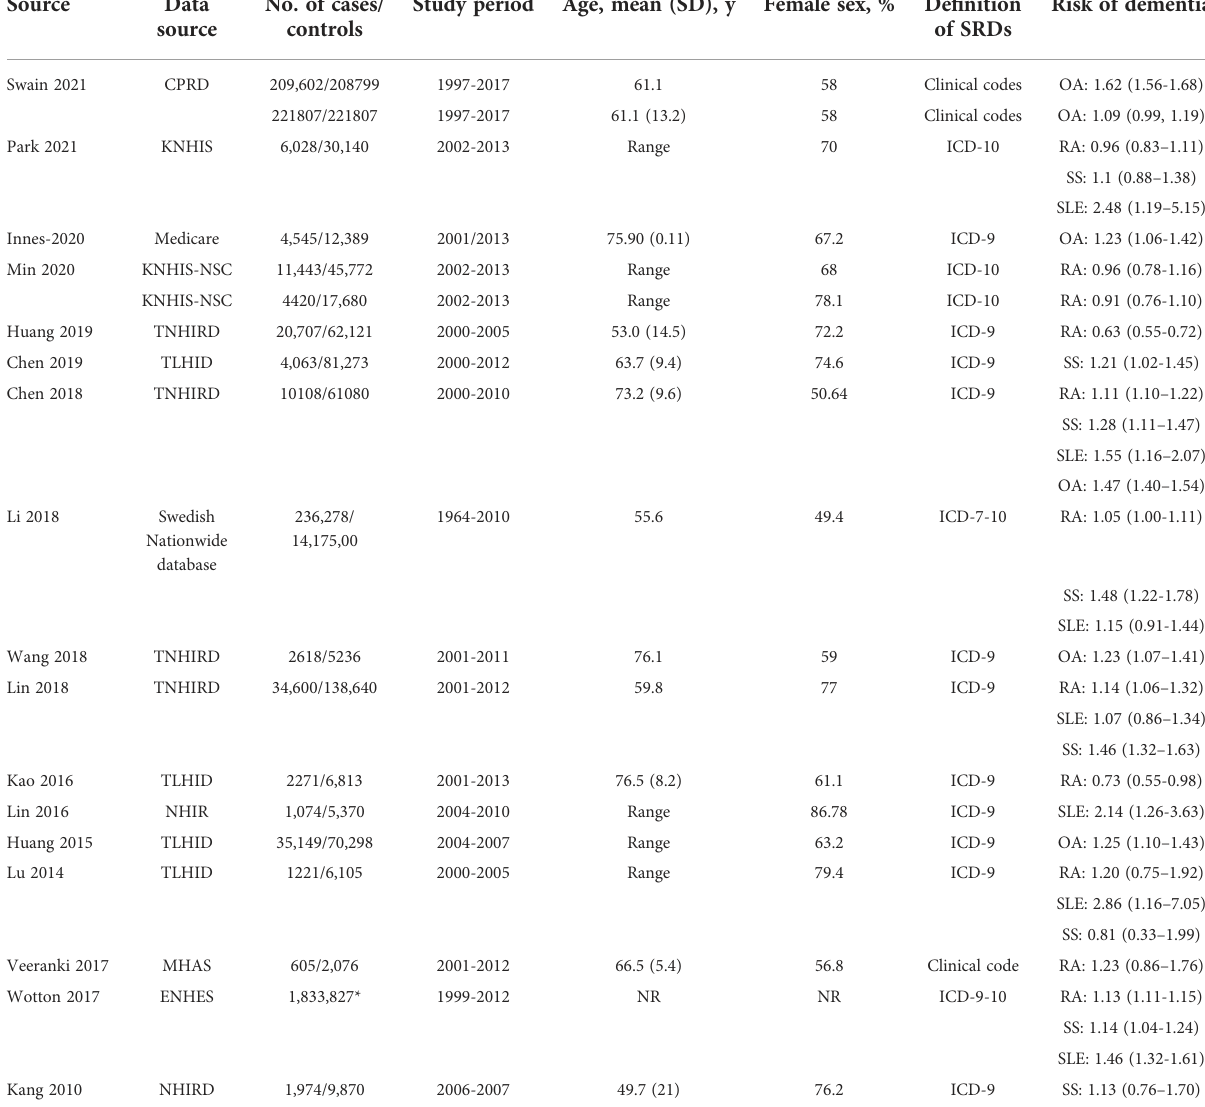
TABLE 1 Baseline characteristics of included